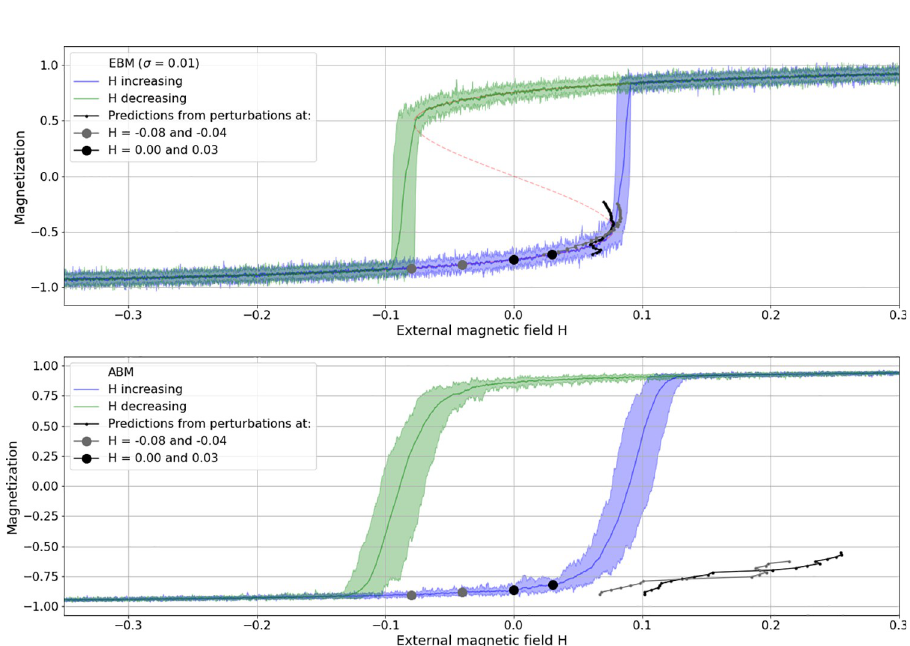
Fig 5. Transition prediction from perturbations to the lower equilibrium branch within the bi-stable region. Light-grey to black dots indicating perturbation parameters, light-grey to black dotted curves indicating corresponding predictions. Perturbation amplitudes kept below the unstable equilibria (red dashed line in top plot) for allowing recovery to the lower equilibria.